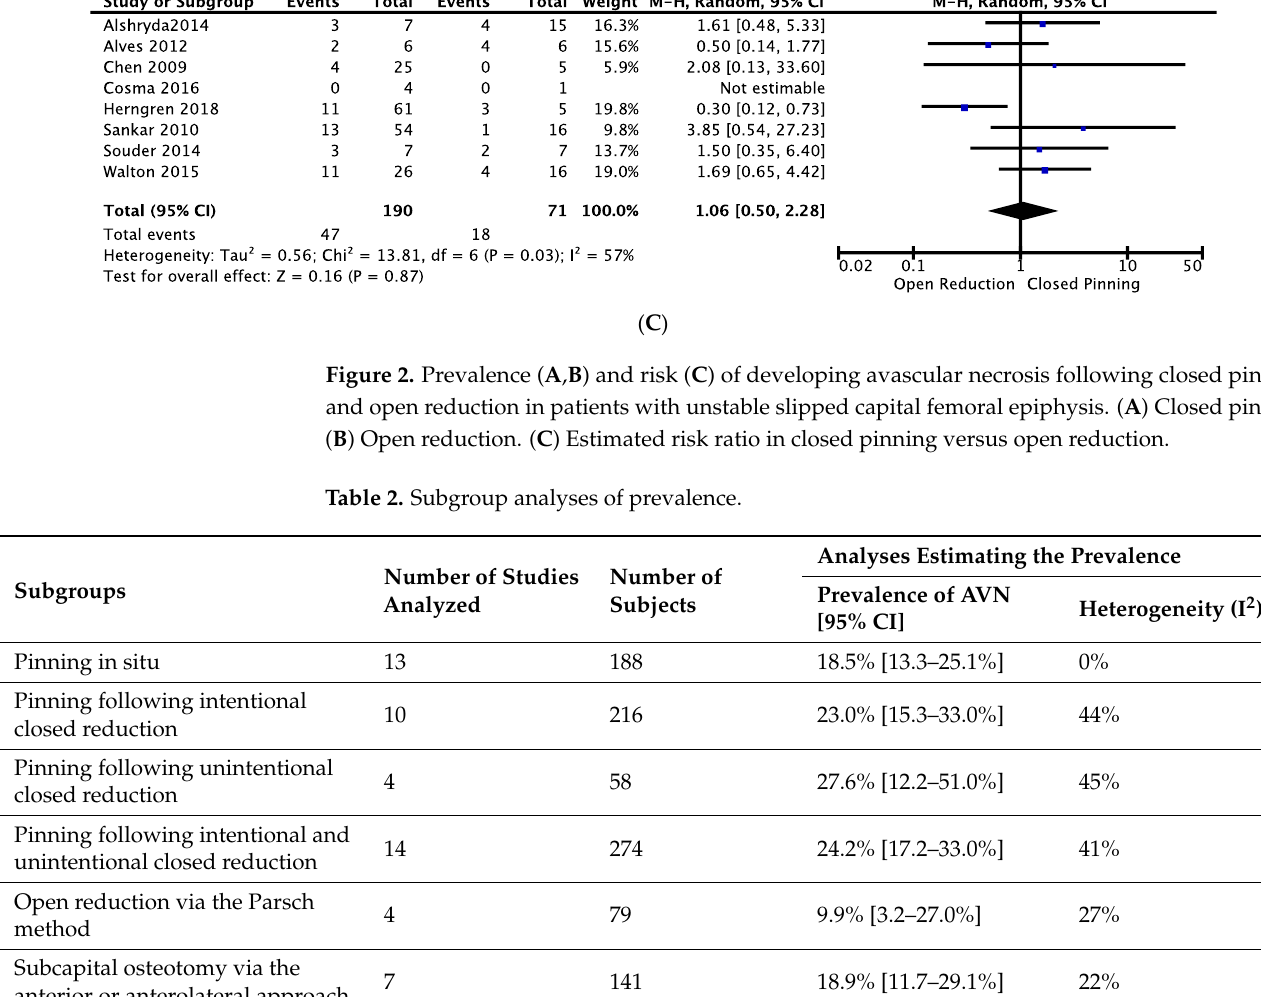
Table 2. Subgroup analyses of prevalence.